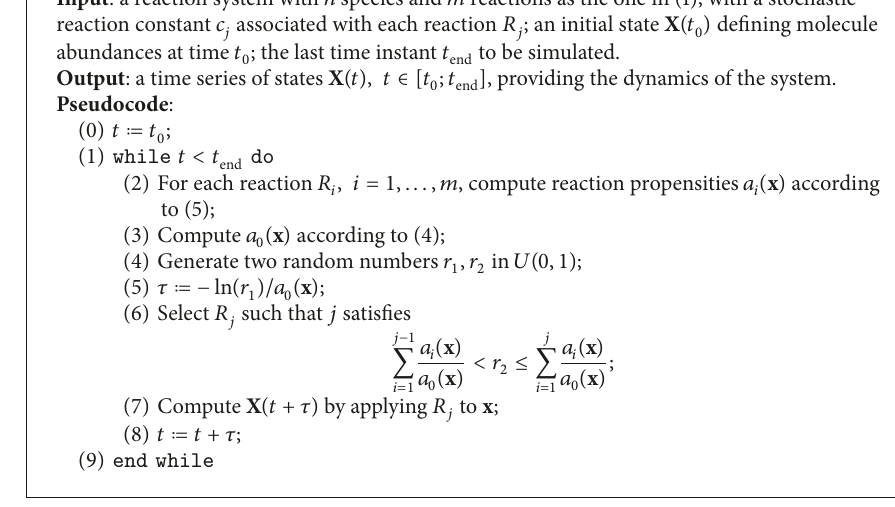
Algorithm 1: Gillespie’s Direct Method (DM).